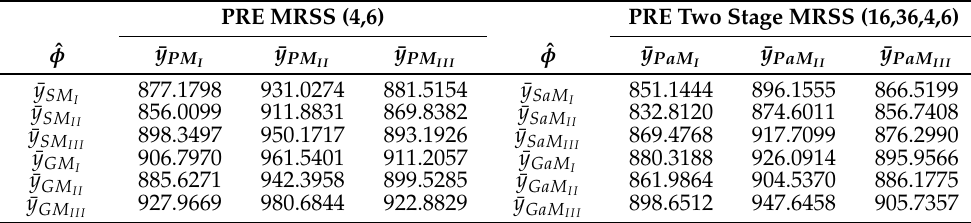
Table 12. PRE values for BMI data for even sample